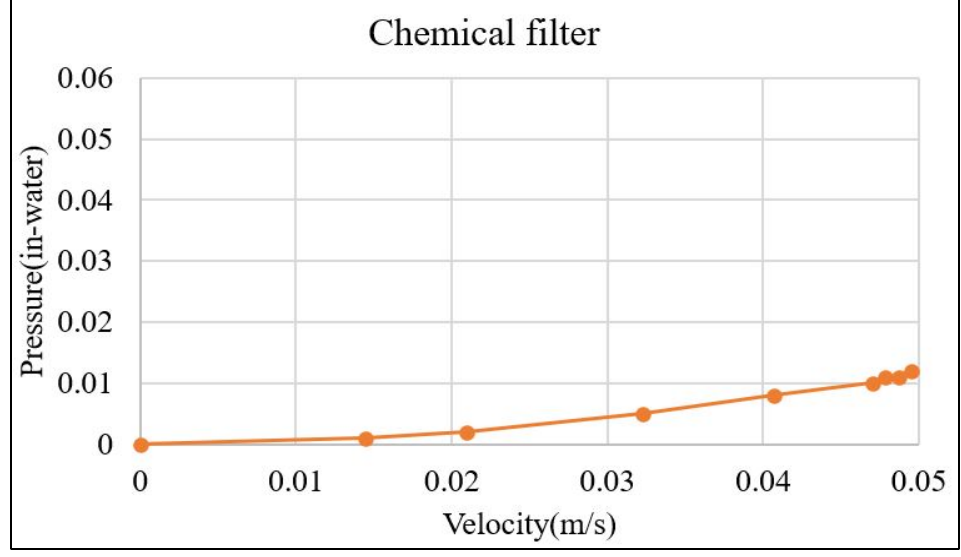
Figure 17. P-Q curve of the chemical filter screen.